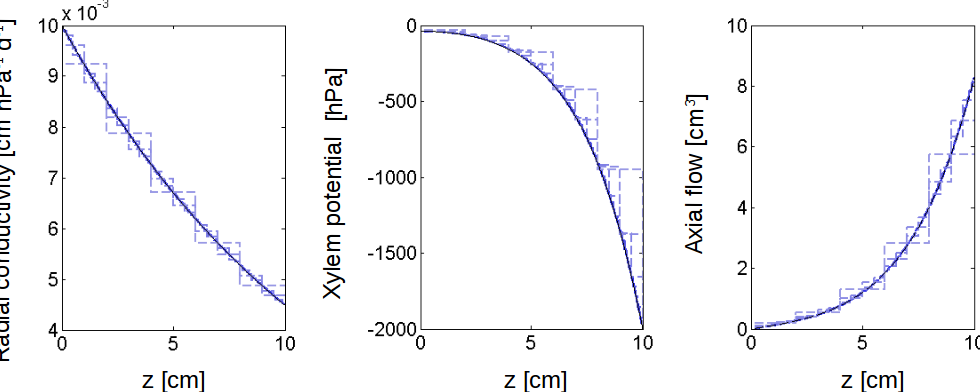
Figure E1. Numerical approximation (blue dashed line) versus analytical solution (dark solid line). The smaller the segment size, the better the numerical